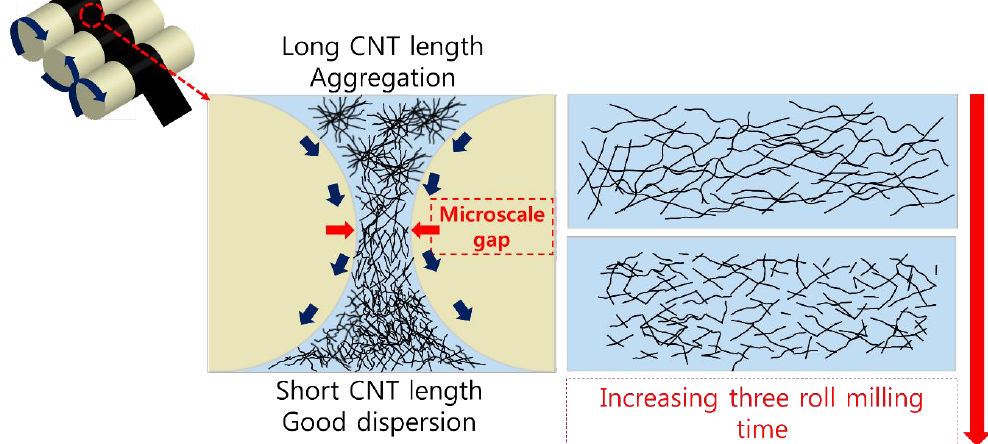
Figure 1. Mechanism of CNT (carbon nanotube) dispersion and aspect ratio changes by shear forces during three-roll milling. Filler length is reduced by increasing the three-roll milling time.